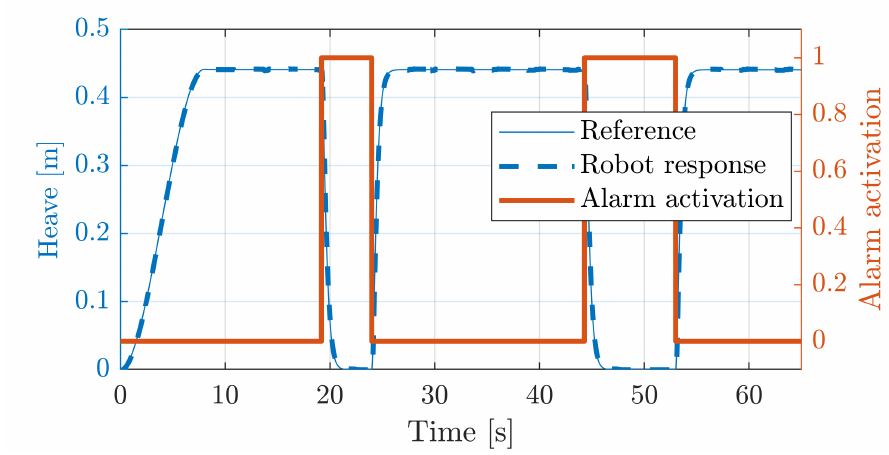
Figure 14. Demonstrates the effect of soft-stopping (yellow block in Figure 6) on heave evolution.